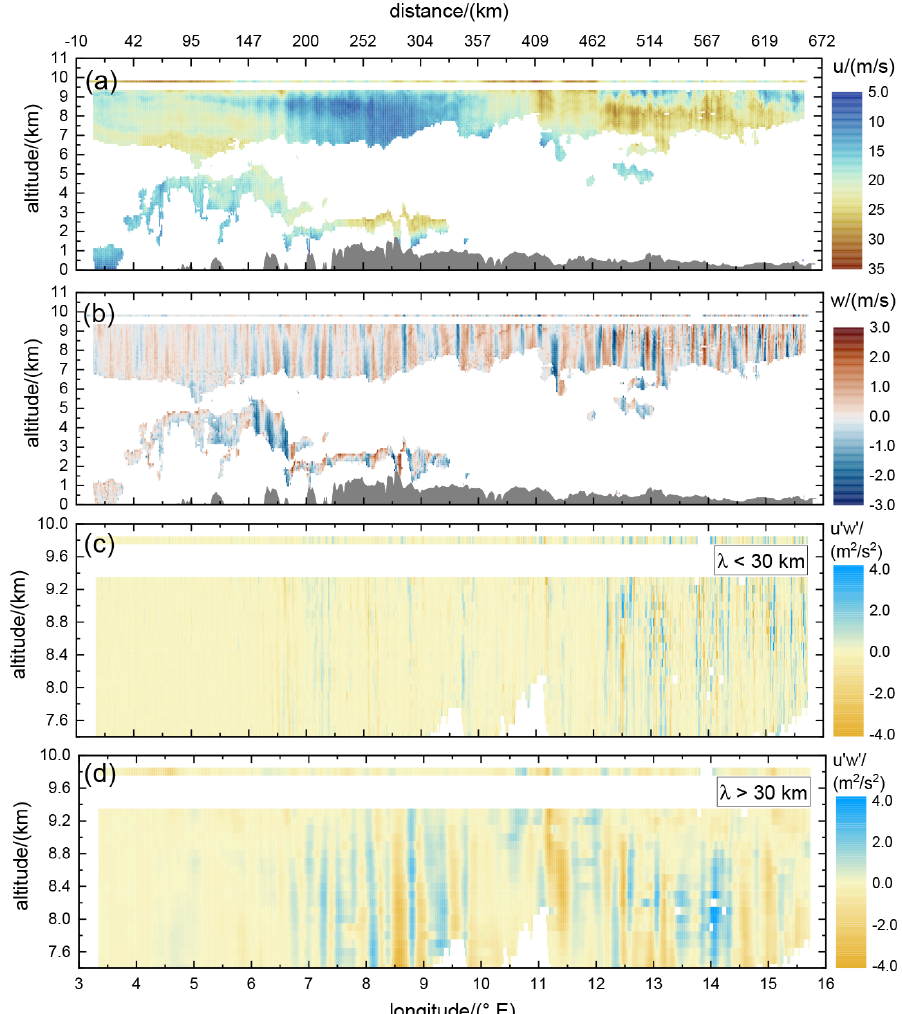
Figure 8. Horizontal wind speed along flight direction u par (a) and vertical wind speed (b) , as well as u (cid:48) par w (cid:48) for the short waves with a wavelength smaller than 30km (c) and longer than 30km (d) retrieved from the 2µmDWL while operating in MF mode on FL3 performed on 28 January 2016 (see also Table 1 and Fig. 1). The thin line at 9 . 8km altitude indicates the corresponding wind speed measured in situ by the nose boom of the aircraft. The orography is denoted by the gray area. For reasons of clarity, only the altitude range between 7 . 5 and 10km with almost full data coverage is depicted in panels (c) and (d)